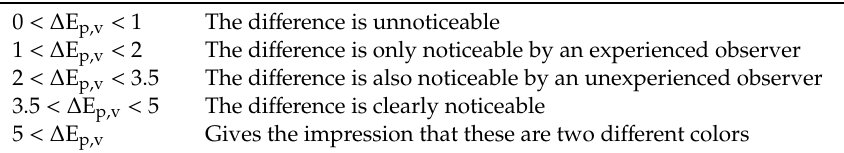
Table 2. Color ranges for ∆ E